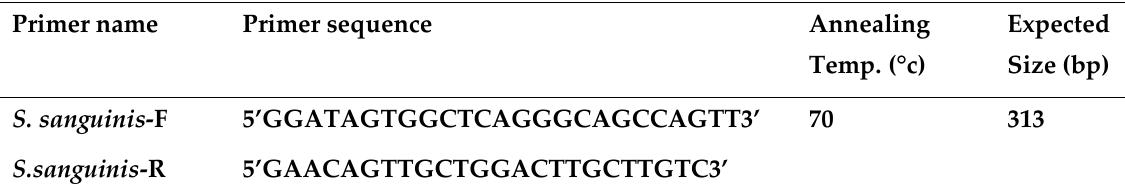
Table 1: The PCR primers in this